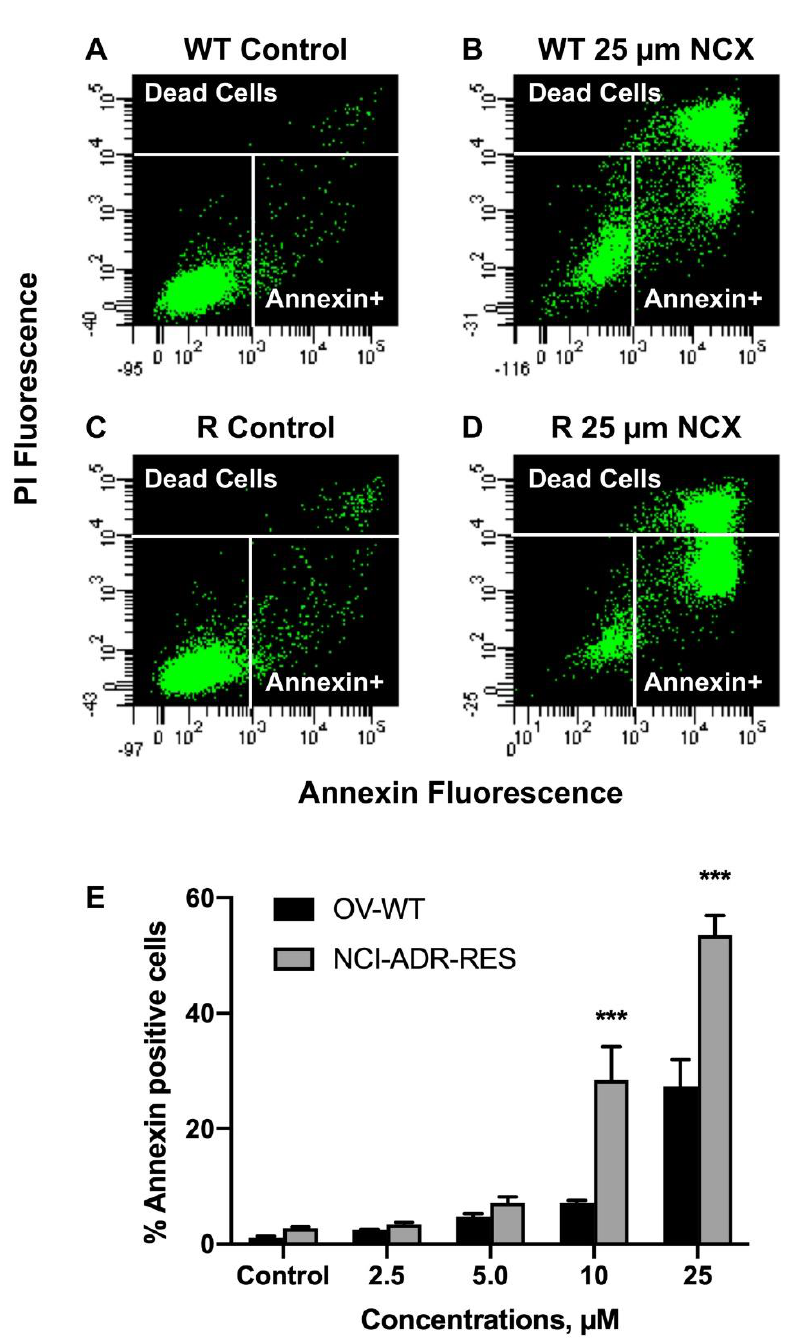
Figure 7. Detection of Annexin positive cells ( A , B ) OVCAR-8, and ( C , D ) in NCI/ADR-RES cells and with different concentrations of NCX4040 for 24 h ( E ). Representative plots ( A – D ) are shown here. *** p -values, <0.001, compared to concentration-matched treatment.